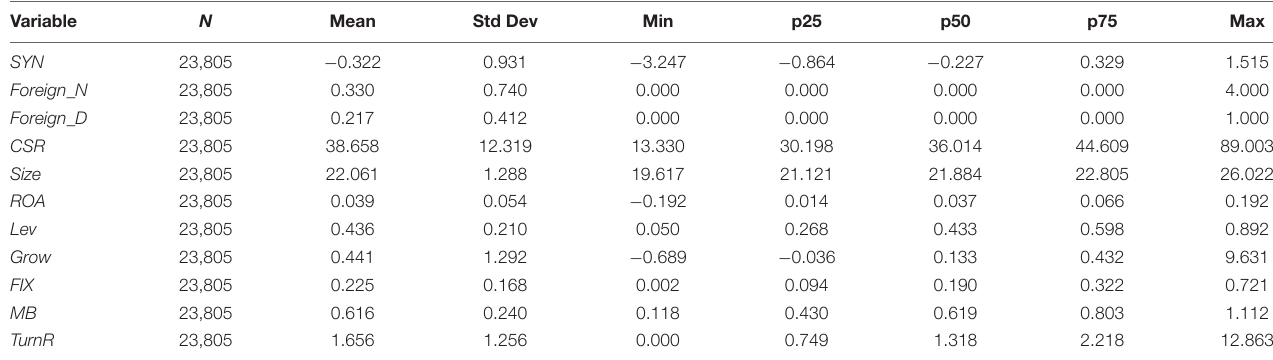
TABLE 2 | Descriptive statistics.